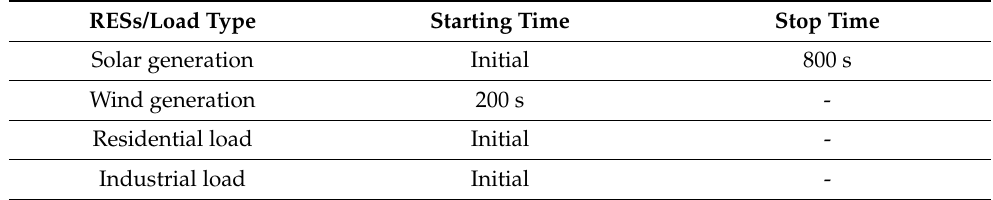
Table 4. Multiple operating conditions of scenarios 2, 3, and 4.